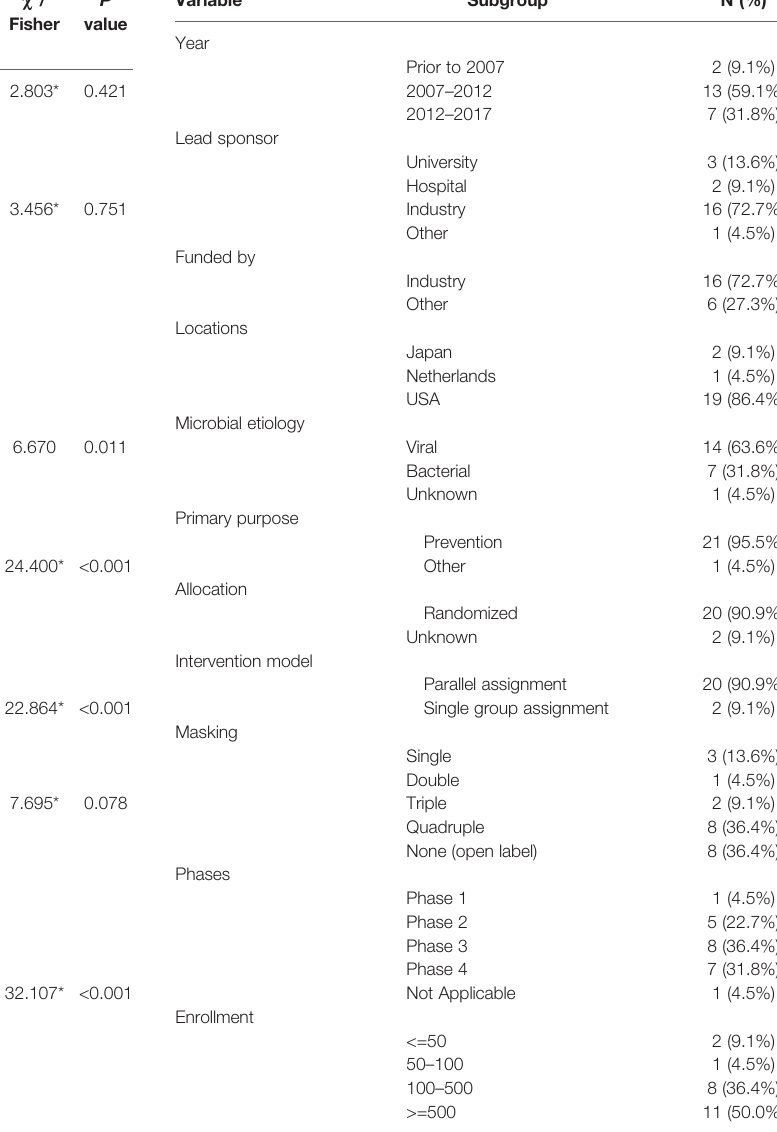
TABLE 4 | Characteristics of vaccine and non-vaccine trials. TABLE 5 | Characteristics of the 22 trials published